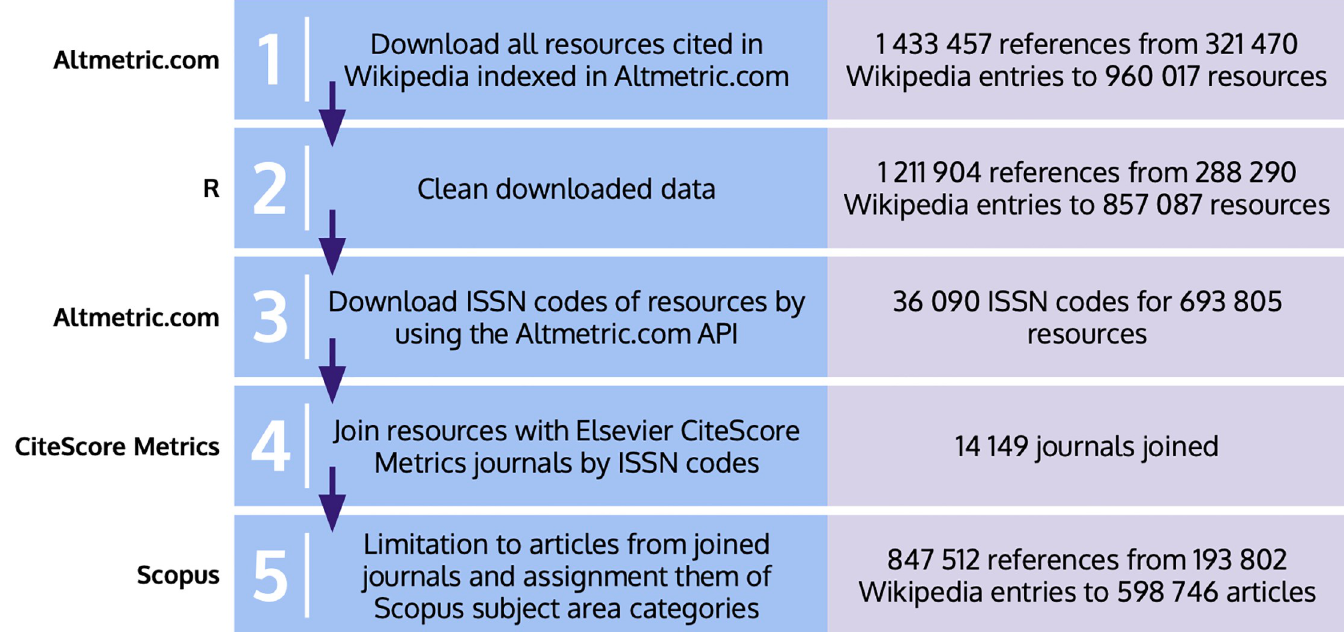
Fig 1. Methodological process of collecting the massive dataset of papers referenced in Wikipedia and assigning them to different scientific categories.